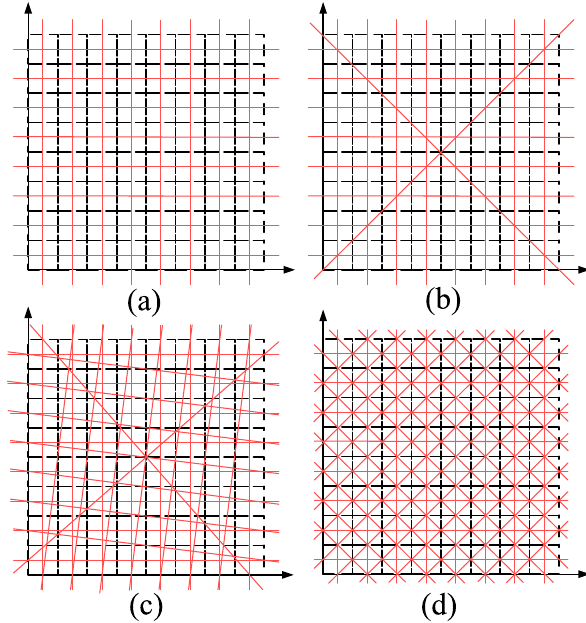
Figure 4. Geometric descriptions of the variety laser beams distribution. ( a ) 16 laser beams, ( b ) 18 laser beams, ( c ) 32 laser beams, and ( d ) 44 laser beams. (Red lines stand for different laser beams.)